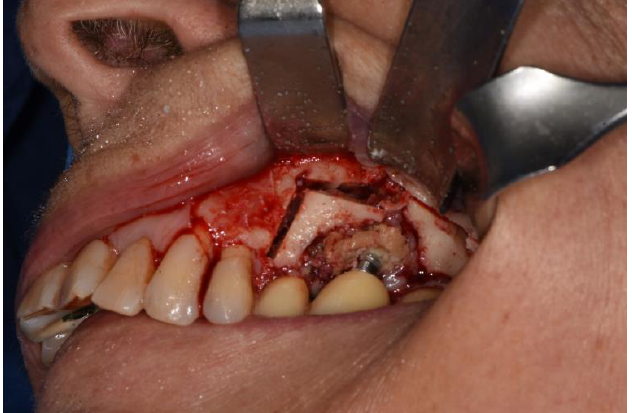
Figure 5. Osteotomy completed polipoid tissue in the maxillary sinus.